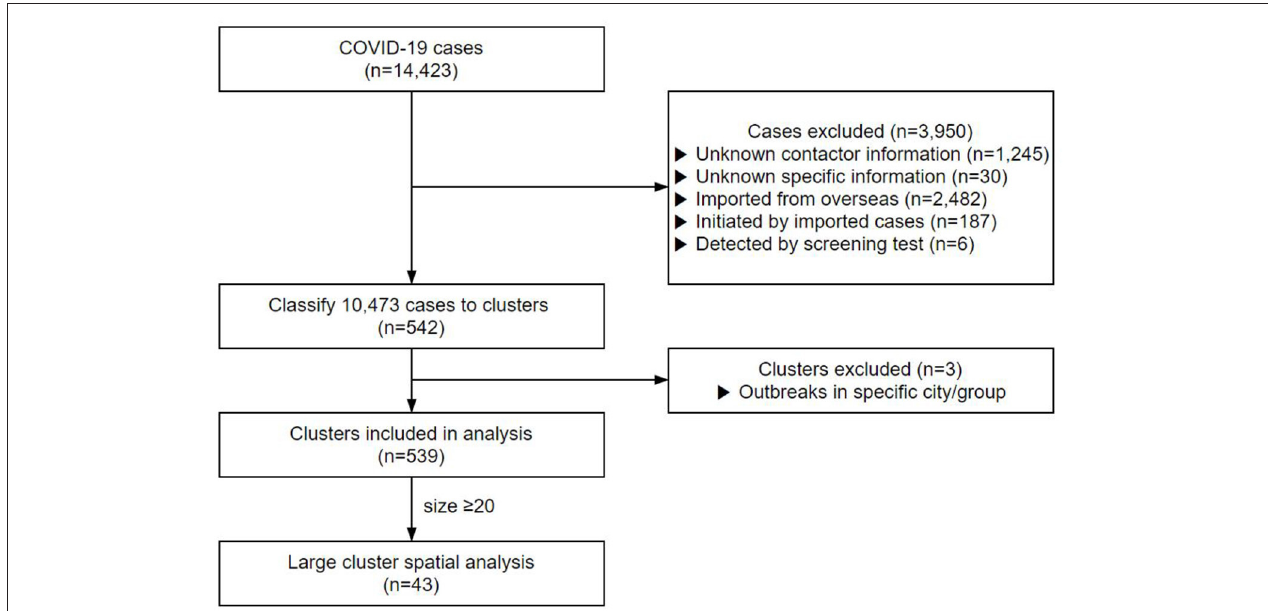
FIGURE 1 | Study population included in the COVID-19 cluster analysis in South Korea.